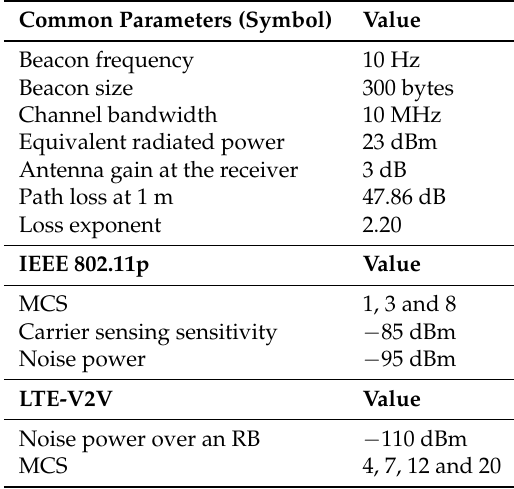
Table 3. The main simulation parameters and settings.